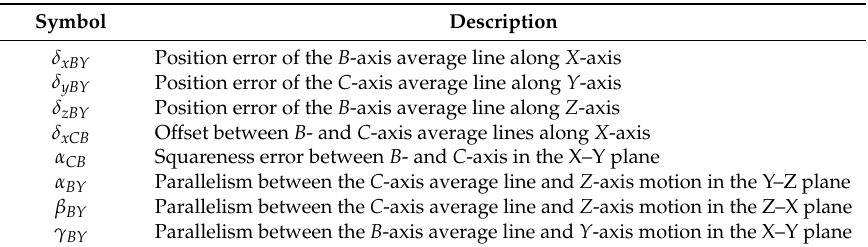
Table 2. List of geometric errors of rotary axes.